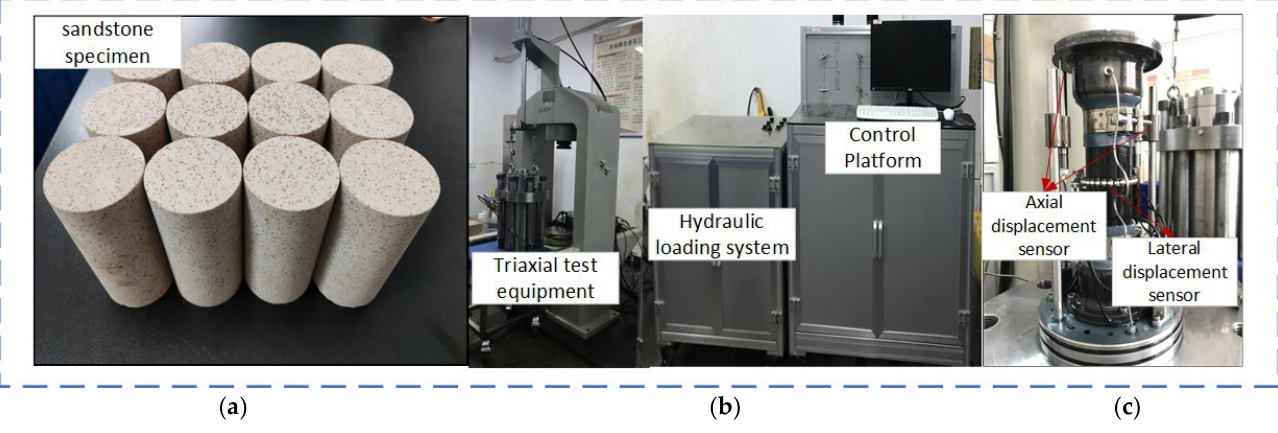
Figure 1. Sandstone specimens and triaxial test equipment (where ( c ) shows the displacement sen- sors, consisting of two axial displacement sensors parallel to the height direction of the specimen and a chain displacement sensor around the middle of the specimen. When the specimen is com- pressed, the axial displacement sensor is compressed at the same time, and the lateral displacement sensor is elongated with the lateral expansion of the sample, with the height of the sample being compressed and the size of the radial expansion able to be measured to obtain the axial and lateral strains. The measuring accuracy is 0.001 mm). ( a ) Sandstone specimens; ( b ) triaxial test equipment; ( c ) displacement sensors.